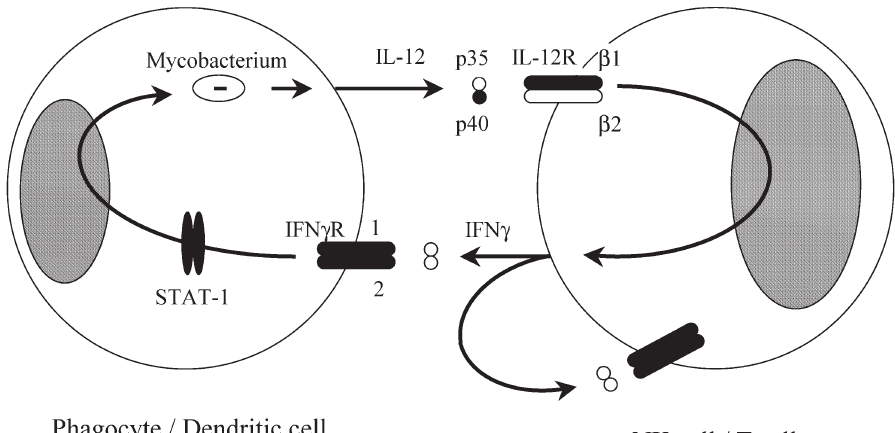
Figure 1 Genetic etiologies of Mendelian suscep- tibility to mycobacterial infection. Cells involved in IFN γ -mediated immunity. IL- 12 is principally secreted by phagocytes and dendritic cells and binds to a het- erodimeric receptor consisting of β 1 and β 2 chains, which is specifically ex- pressed on NK and T lymphocytes. IFN γ is secreted by NK and T lymphocytes and binds to a ubiquitous receptor made of two chains, a ligand-binding (IFN γ R1) and a signaling-associated chain (IFN γ R2). STAT-1 is phosphorylated in re- sponse to IFN γ and is translocated to the nucleus as a homodimer. Five molecules (in black) have been found to be mutated in certain patients with severe mycobac- terial